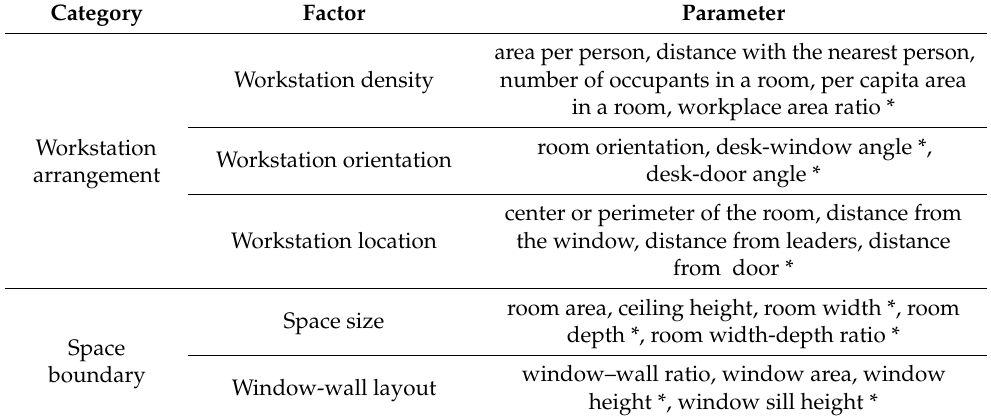
Table 1. Office layout characteristic network.